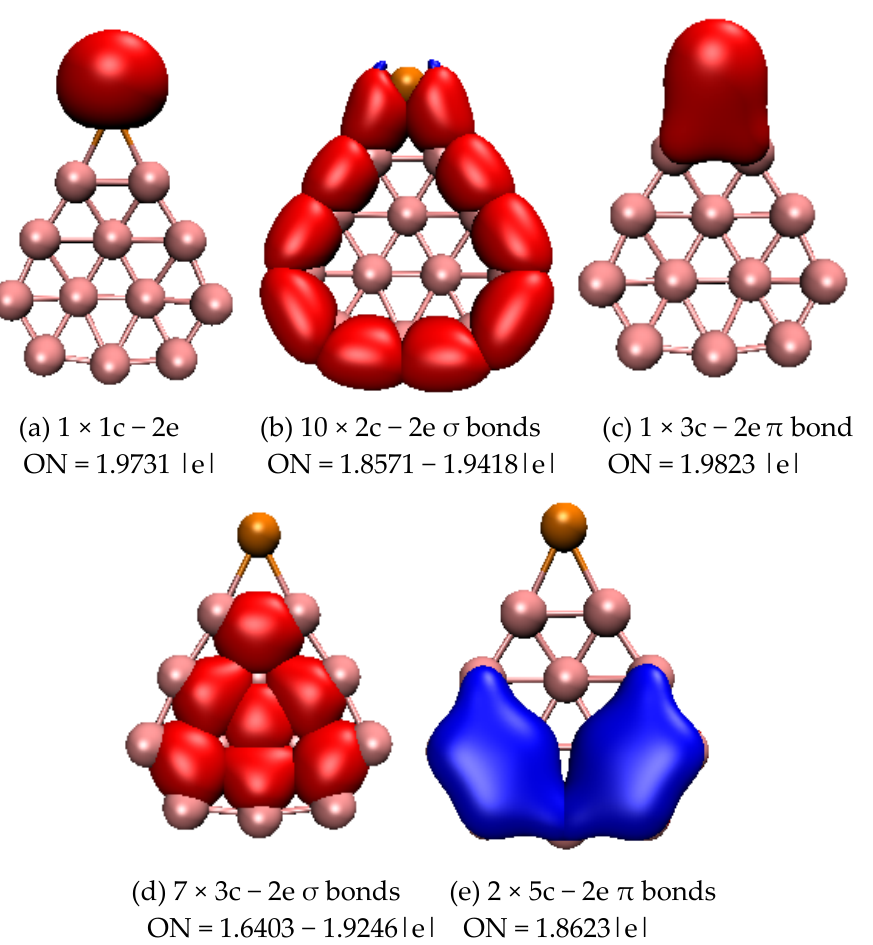
Figure 4. Bonding patterns of SeB 9 − . ON is occupation number and the orange ball is Se atom. (a) 1 × 1c − 2e, ON = 1.9644|e|; (b) 1 × 2c − 2e σ bond, ON = 1.9965|e|; (c) 1 × 2c − 2e σ bond, ON = 1.9523|e|; (d) 1 × 2c − 2e π bond, ON = 1.9884 |e|; (e) 1 × 2c − 2e π bond, ON = 1.9884|e|; (f) 6 × 2c − 2e σ bonds , ON = 1.9247|e|; (g) 6 × 3c − 2e σ bonds, ON = 1.7547|e|.